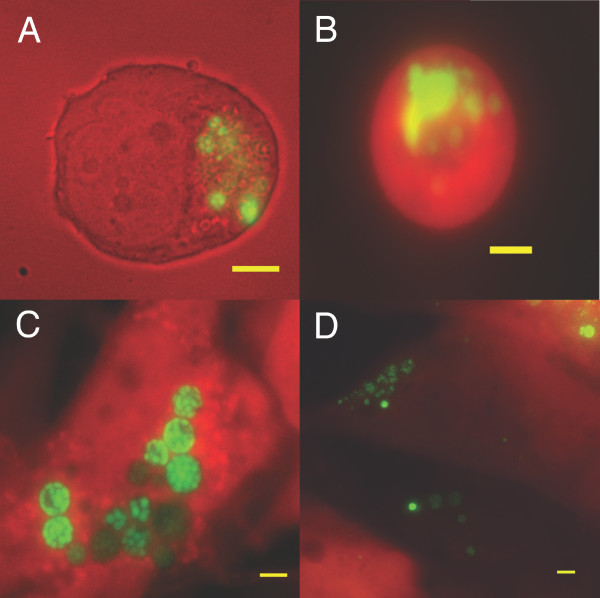
Images of GFP/Ap growing within various host cells. HL-60 (A) with partial bright field to illuminate the non fluorescent host cell. Tick cell ISE6 (B) expressing DSred and containing indistinct bacteria in morulae. Monkey RF/6A (C) and human HMEC-1 (D) endothelial cells expressing mCherry and containing GFP/Ap morulae with distinct bacteria. Bars 5 μm.